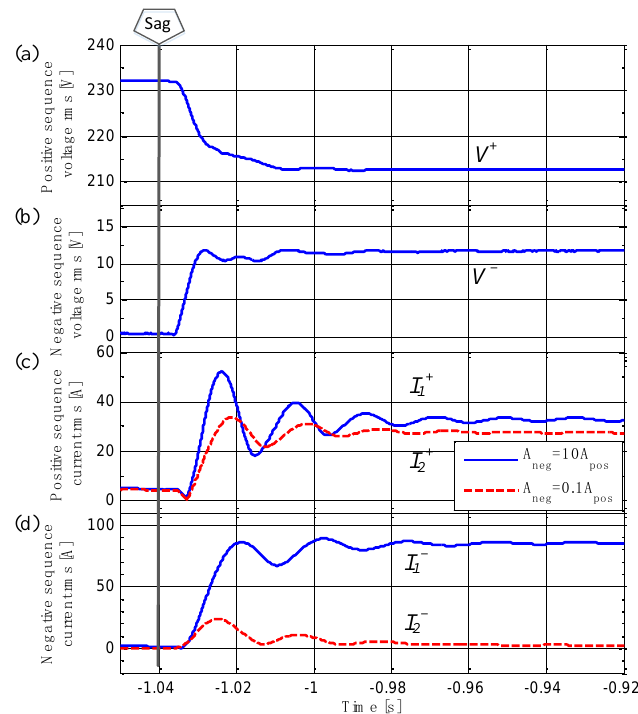
Figure 18. Two SPC-based converters working with different negative-sequence virtual admittances. Comparison of the negative-sequence current injection of the two converters during an unbalanced sag: ( a ) positive sequence PCC voltage rms; ( b ) negative sequence PCC voltage rms; ( c ) positive sequence current rms; and ( d ) negative sequence current rms.